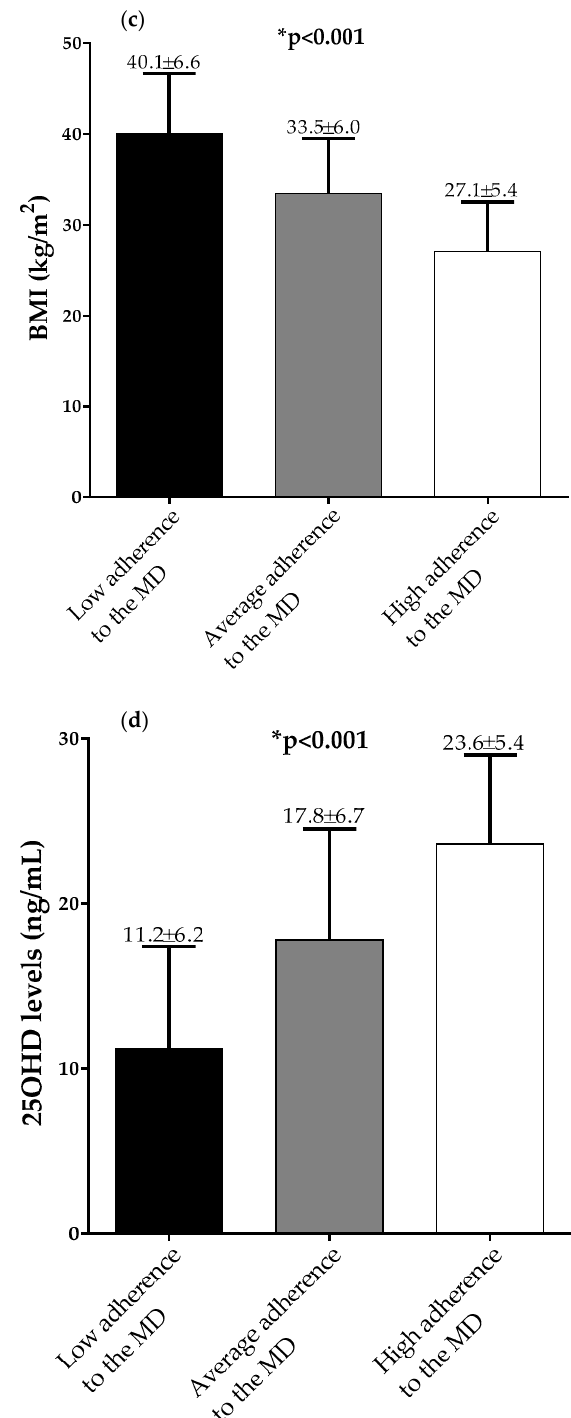
Figure 2. BMIs ( a ) and PREDIMED scores ( b ) across 25OHD categories, and BMIs ( c ) and 25OHD levels ( d ) across PREDIMED categories, in females. A * p value denotes a significant difference ( p < 0.05). Table 4 reported the descriptive data of PREDIMED score and 25OHD categories according to PREDIMED categories and stratified by gender. PREDIMED scores were higher in females than in males in the low and high PREDIMED categories ( p < 0.001 and p = 0.03, respectively).